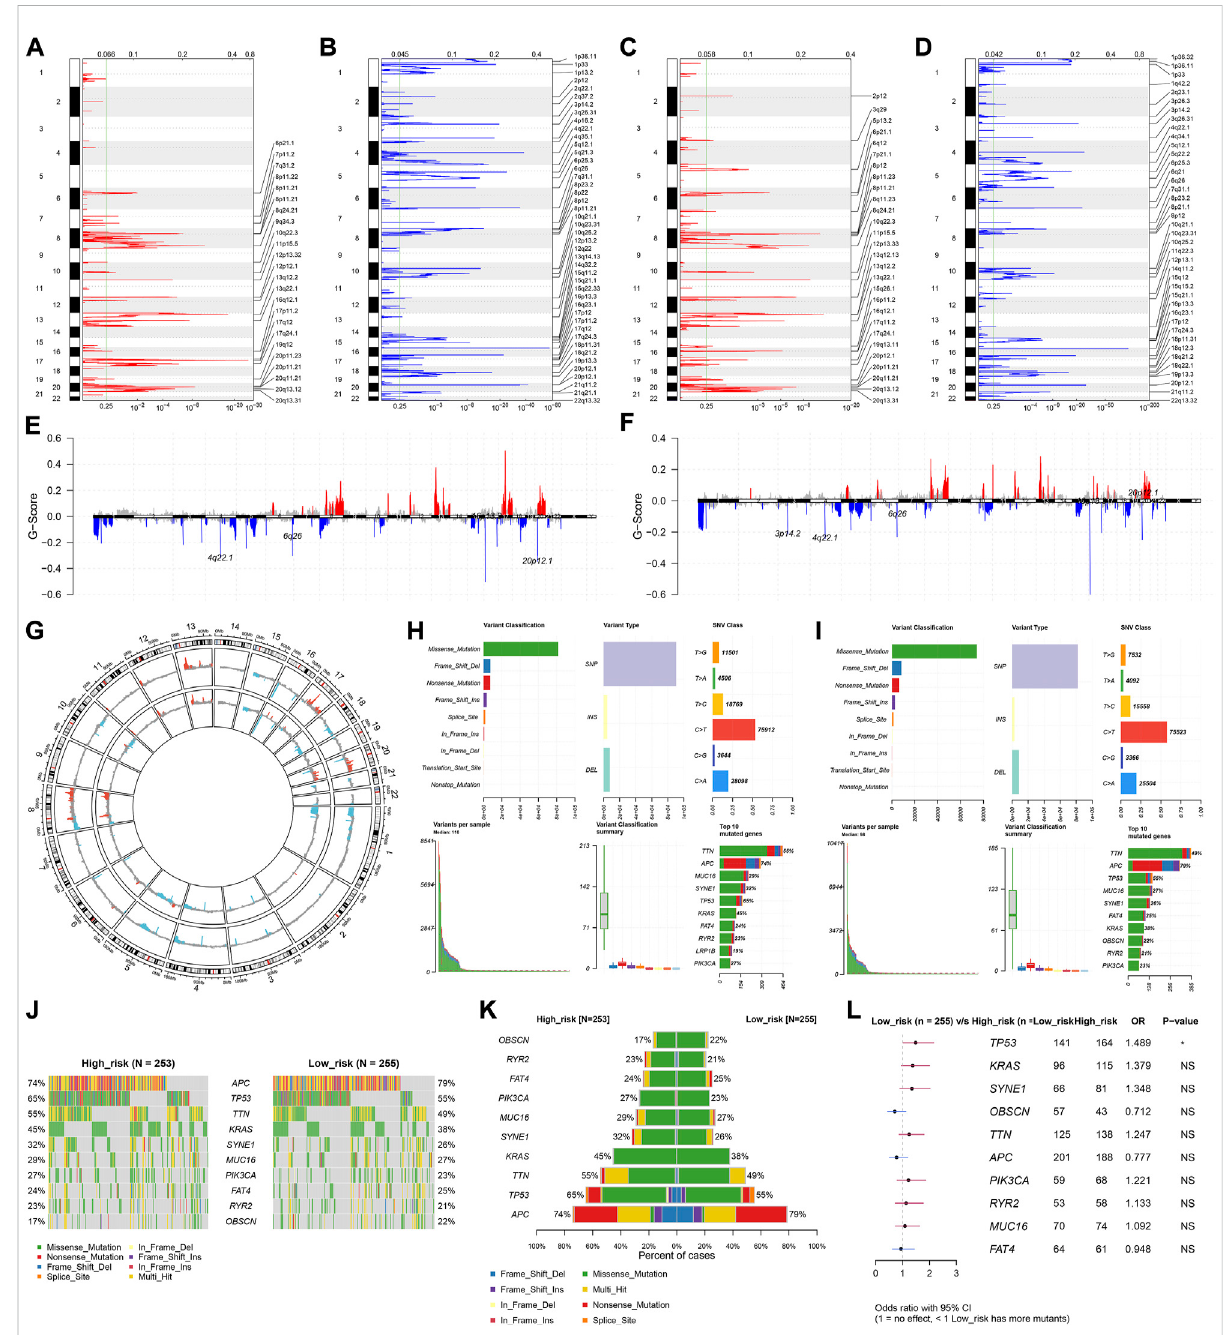
FIGURE 7 Differences in CNV and mutation between high- and low-risk subsets. (A – D) Copy number gains and deletions identi fi ed in (A,B) high- and (C,D) low-risk subsets by GISTIC 2.0. X-axis represents the CNV fractions on each chromosome, and y-axis represents the chromosome number. The mutation location on the chromosome is marked on the right side. Red and blue represent the signi fi cantly ampli fi ed and deleted regions, respectively. (E – G) Signi fi cantgainsanddeletionsofcopynumberinhigh-andlow-risksubsets. (H,I) Landscapeofmutationsinhigh-andlow- risk subsets. (J,K) Difference in the frequencies of the top 10 mutated genes between subsets. (L) Forest plot of the correlation between mutated genes and high-risk. N =